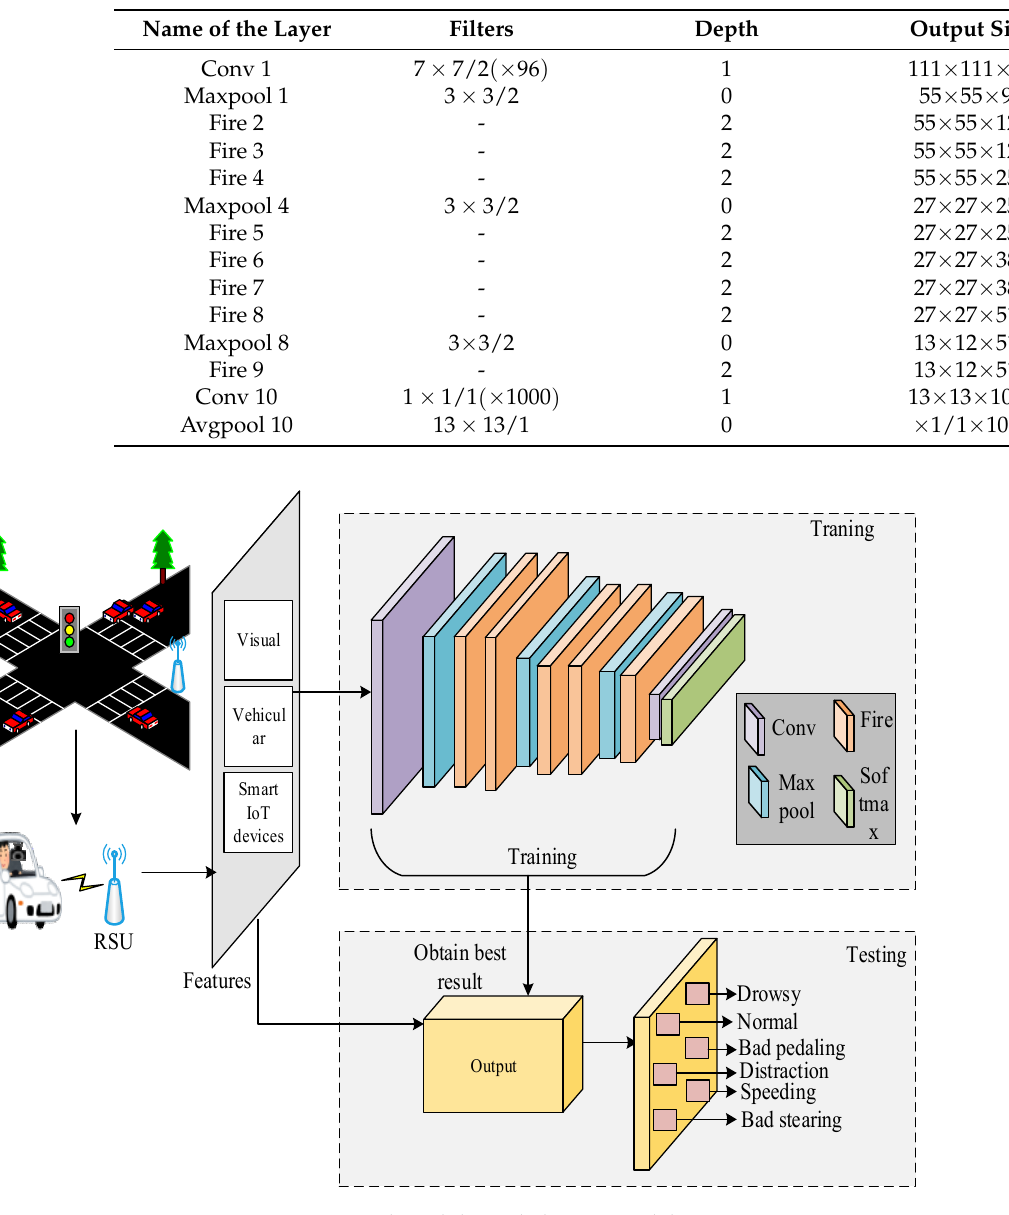
Table 4. Layers of SqueezeNet.